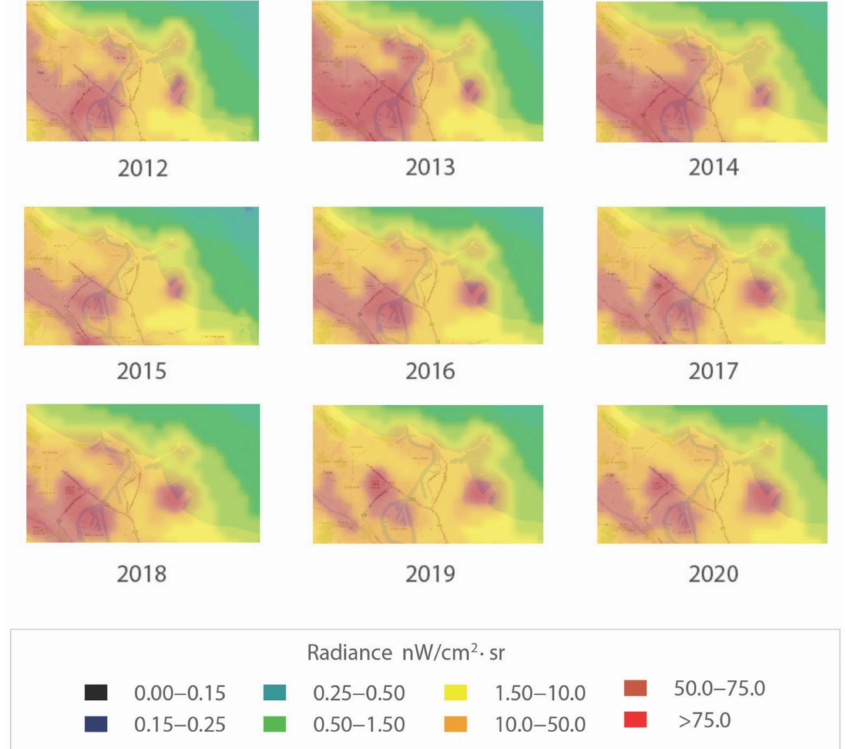
Figure 8. The composition of light pollution maps for the years 2012–2020 for the Wisłouj´scie Fortress Natura 2000 site in Gda´nsk and the areas adjacent to it. Source: authors’ elaboration based on the graphics displayed by the LPM service.